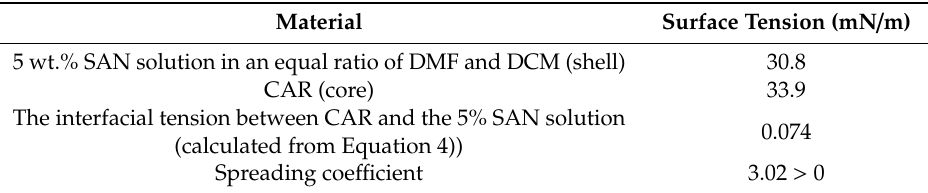
Table 1. Surface tension of core and shell